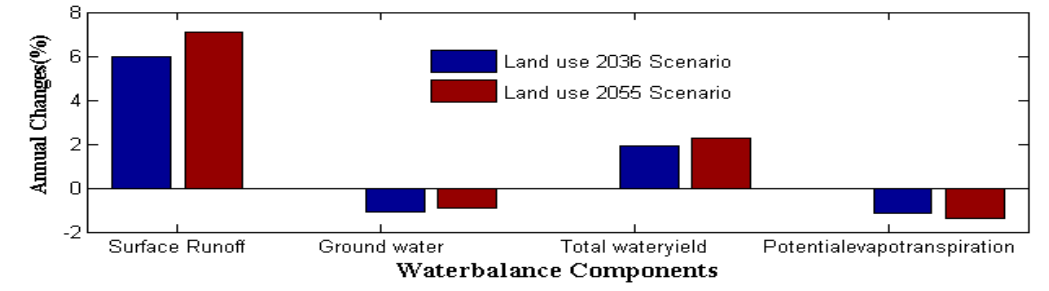
Figure 8. Impacts of land use / land cover change on water balance